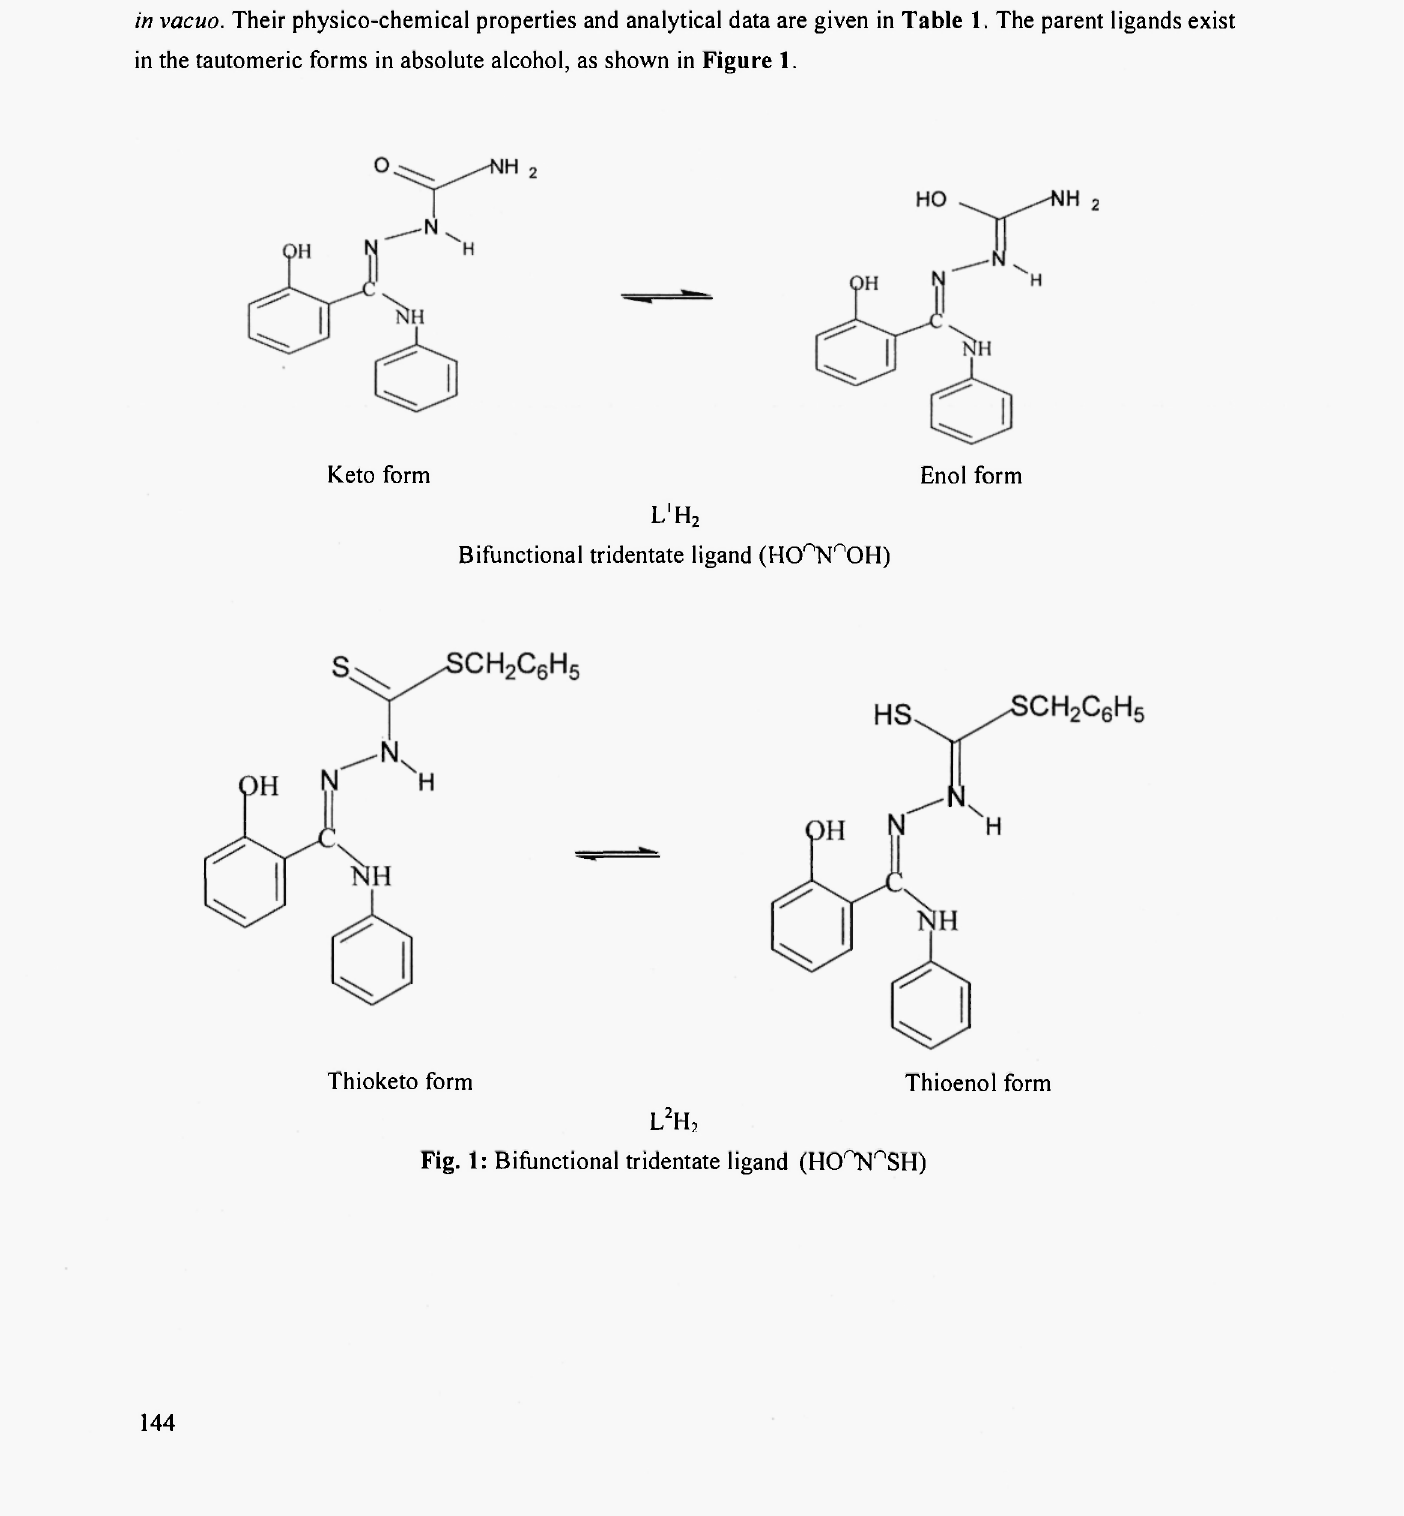
Fig. 1: Bifunctional tridentate ligand (HO°N n